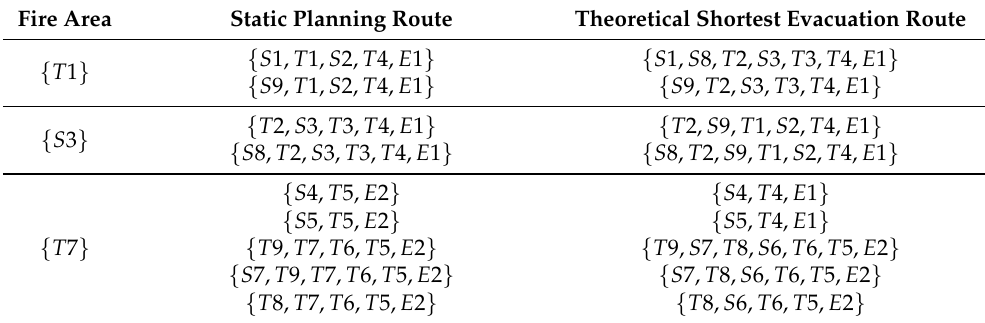
Table 9. Hazardous a priori routes in different fire areas.